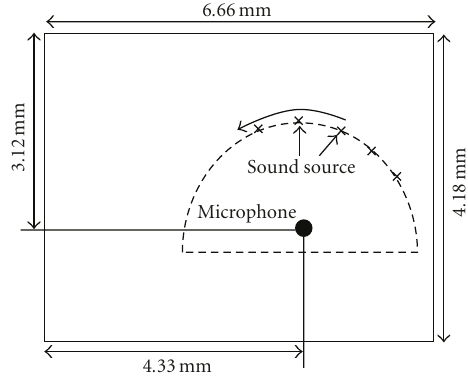
Figure 4: Experiment room environment for